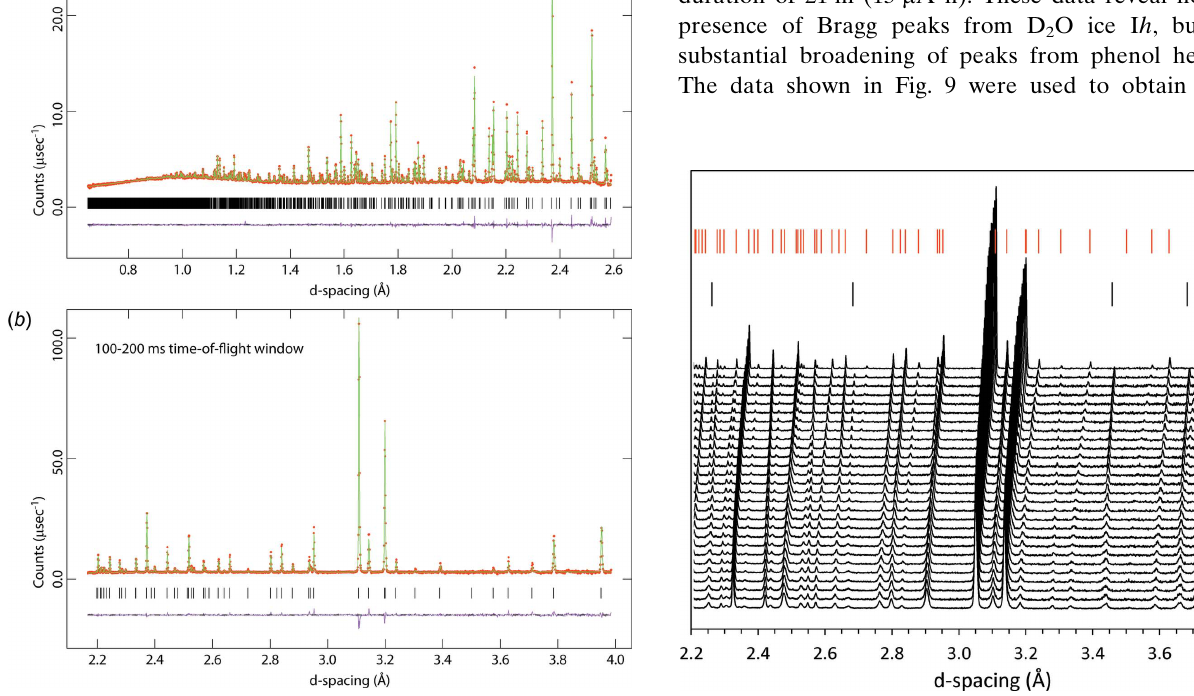
Figure 9 Stack-plot of neutron powder-diffraction data measured on cooling in 10 K increments from 280 K (top) to 10 K (bottom). Red tick marks indicate the Bragg reflections of phenol hemihydrate at 280 K and the black tick marks show the positions of reflections from ice I h at 270 K. Note the broadening of all peaks that becomes substantial below (cid:3) 140 K.